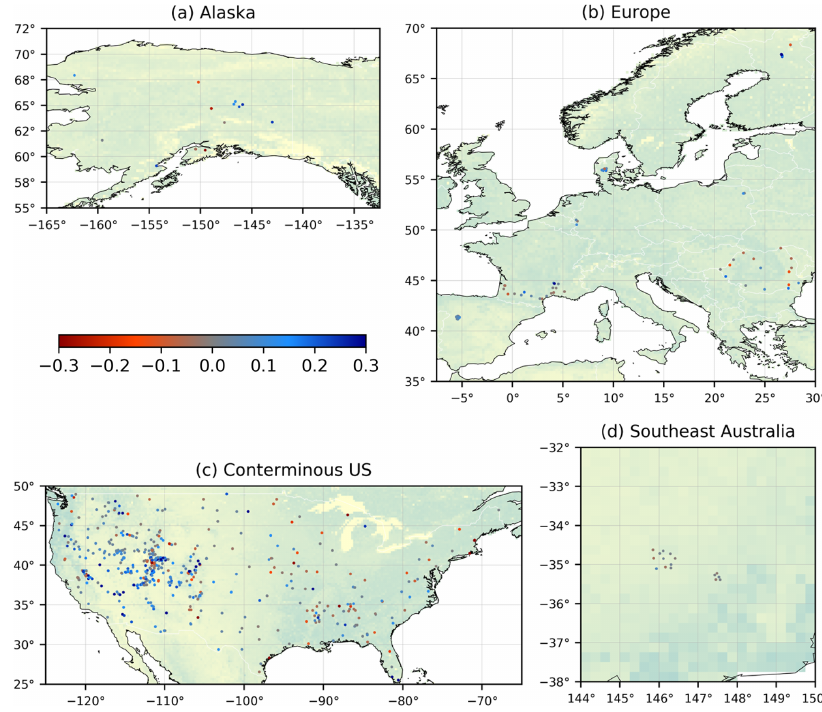
Figure 5. Three-hourly Pearson correlations ( R ) obtained by MeMo minus those obtained by ESA-CCI. Blue indicates that MeMo performs better, whereas red indicates that ESA-CCI performs better. A map of long-term mean LAI (Baret et al., 2016) is plotted in the